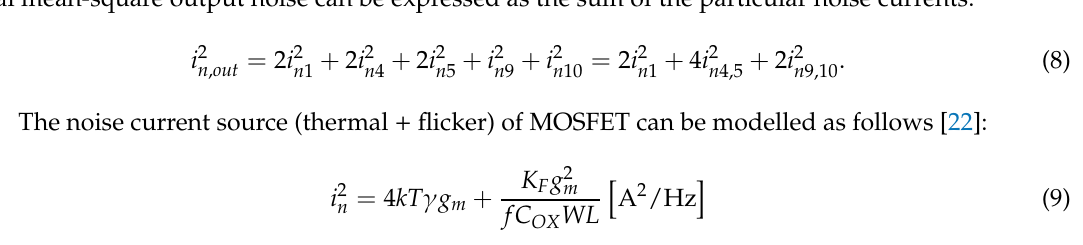
Figure 9. The simplified electrical diagram of the LTA for the noise calculation.